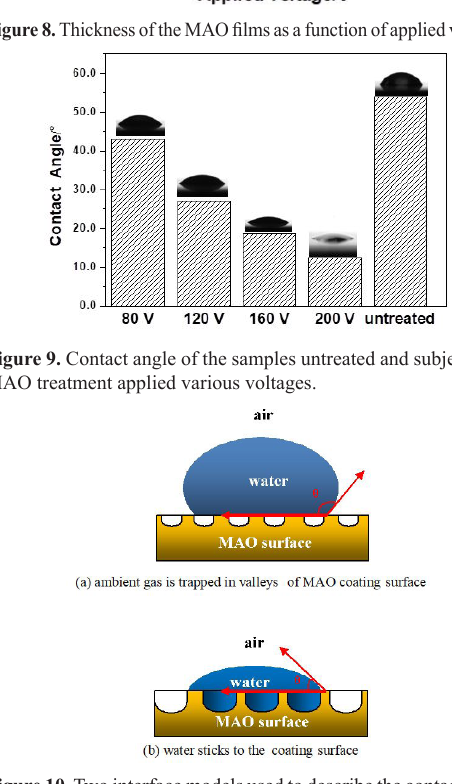
Figure 10. Two interface models used to describe the contact angle of the MAO coatings prepared at various voltages (a) ambient gas is trapped in valleys of MAO coating surface. (b) water sticks to the coating